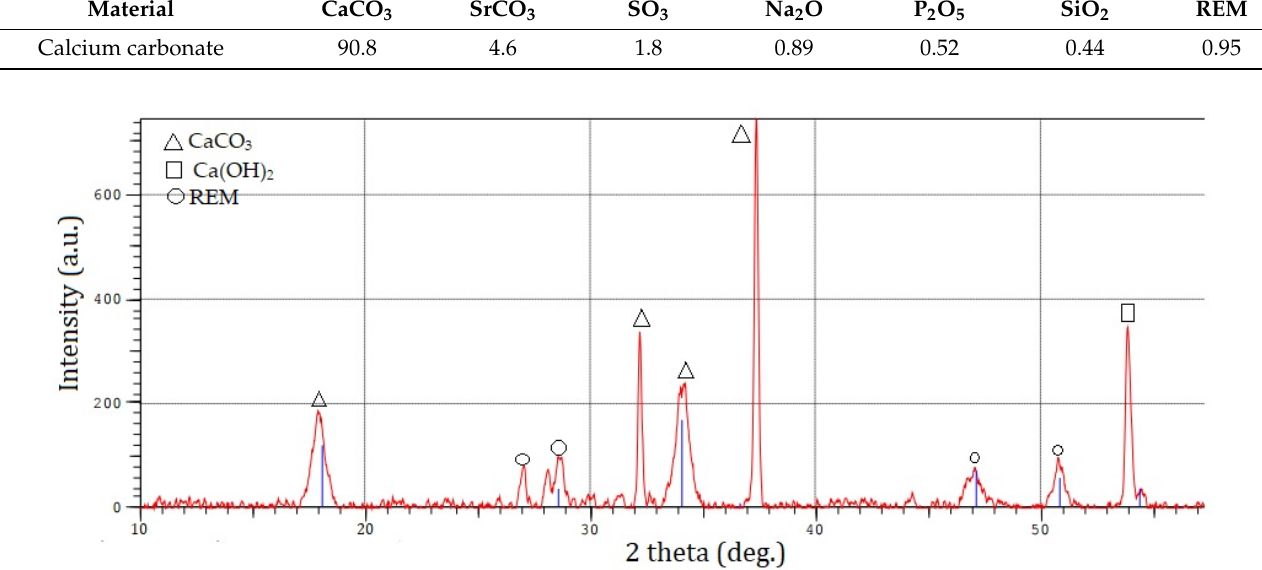
Figure 5. X-ray pattern of calcium carbonate. Table 6. Chemical composition (wt. %) of calcium carbonate laboratory samples.